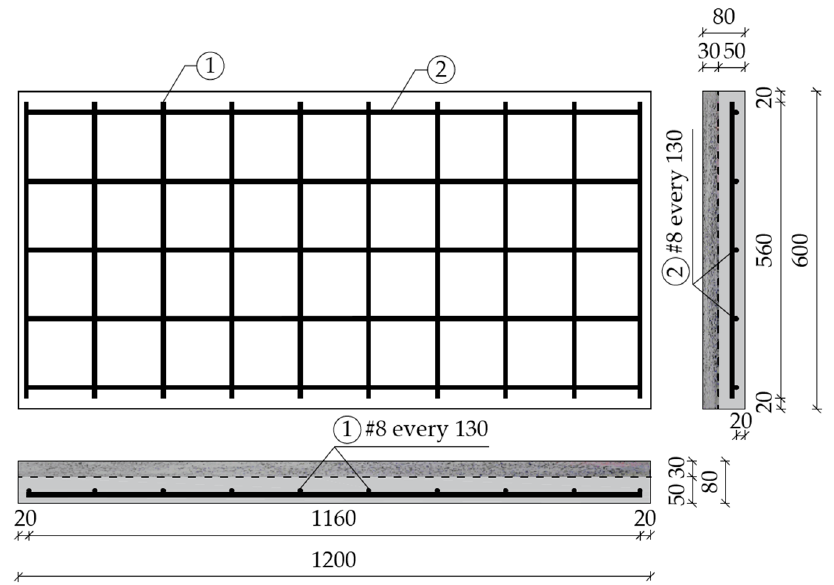
Figure 2. Reinforcement of the slab element.